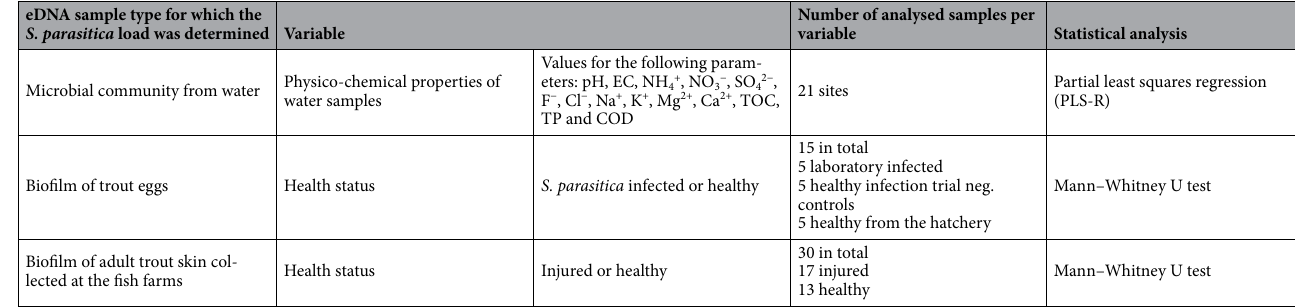
Table 2. Analyses of the effect of different variables on S. parasitica